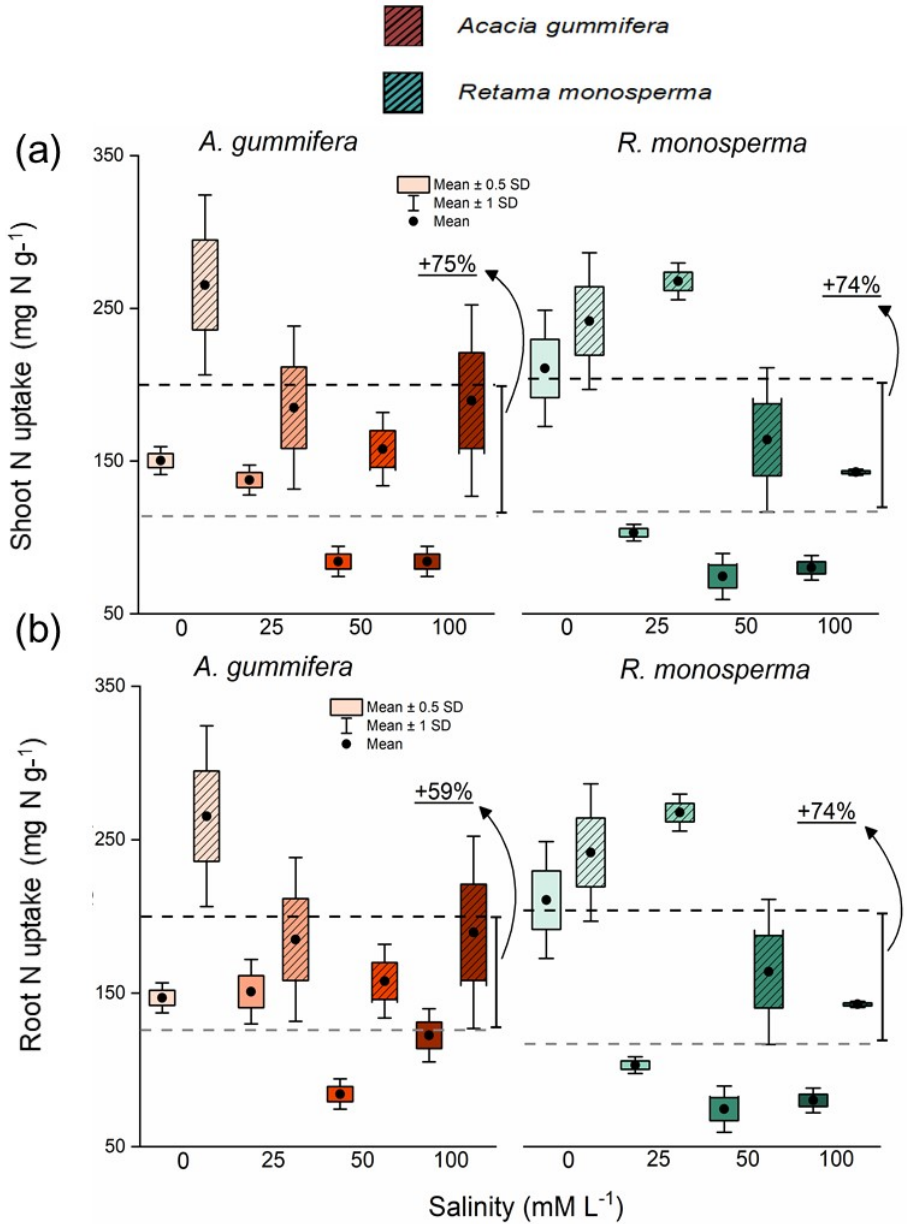
Figure 5. Boxplots of N uptake in the shoot ( a ) and in the root ( b ) of the non-inoculated and mycorrhizal inoculated Acacia gummifera and Retama monosperma plants grown under different salinity levels (0, 25, 50 and 100 mM NaCl). The average values of mycorrhizal shoot and root N uptake response for A. gummifera and R. monosperma species are shown by the percentage of increased value. Mycorrhizal inoculated plants are represented by dashed boxplots for both A. gummifera and R. monosperms species. At the different salinity concentration, A. gummifera species are represented by antiwhite and brown colors, and R. monosperma species are shown by tea-green, and green colors, respectively.